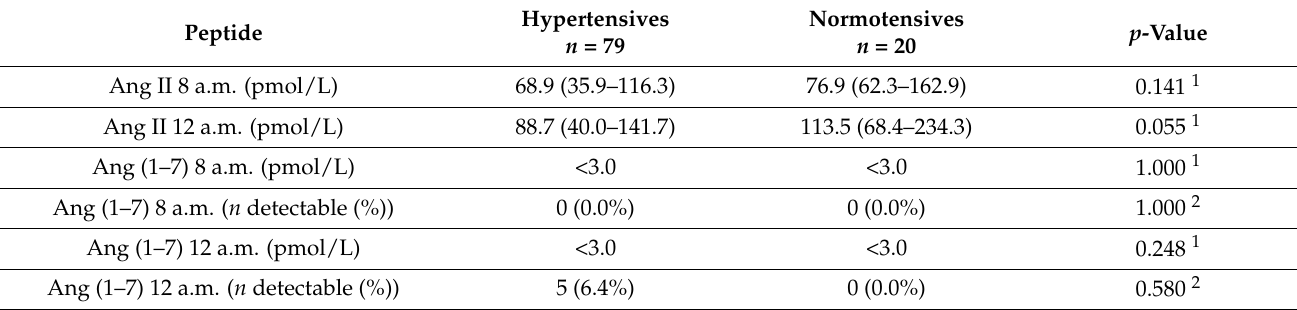
Table 2. Baseline Ang II and Ang (1–7) equilibrium concentrations in the morning (8 a.m.) and at noon (12 a.m.) for hypertensive patients before treatment initiation and normotensive controls, presented as median (interquartile range). Peptide